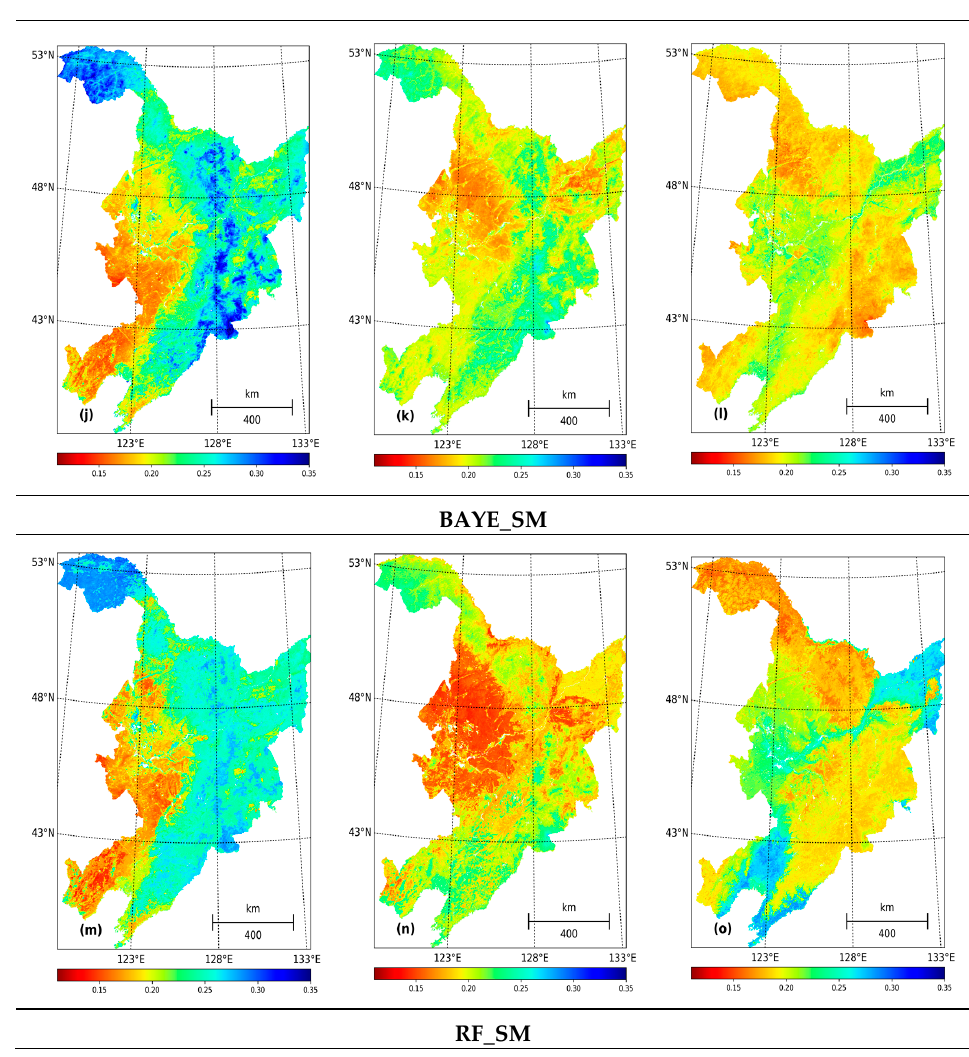
Figure 6. Comparison of ESA CCI SM and CART_SM, KNN_SM, BAYE_SM, RF_SM in April 2003,